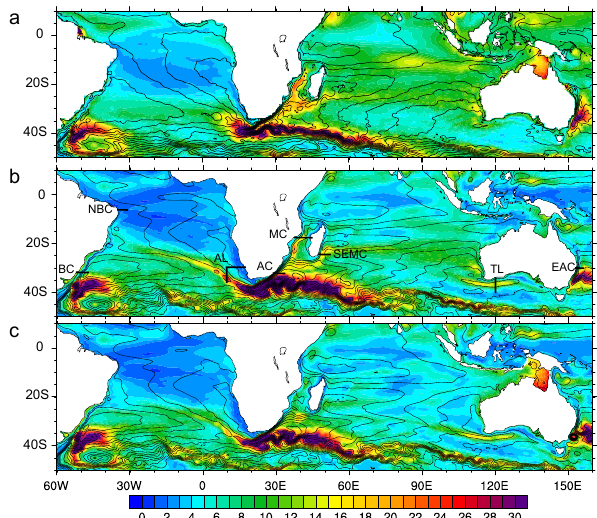
Fig. 2. Contour of mean dynamic topography and standard devia- tion (colors, in cm) from (a) altimetry data, (b POP CTRL and (c) POP noITF. Sections used for Table 2 are also shown here (EAC: East Australian Current at 30 ◦ S, TL: Tasman Leakage, NBC: North Brazil Current at 6 ◦ S, SEMC: South East Madagascar Current, BC: Brazil Current at 32 ◦ S, AL: Agulhas leakage, AC: Agulhas Current at 32 ◦ S, MC: Mozambique